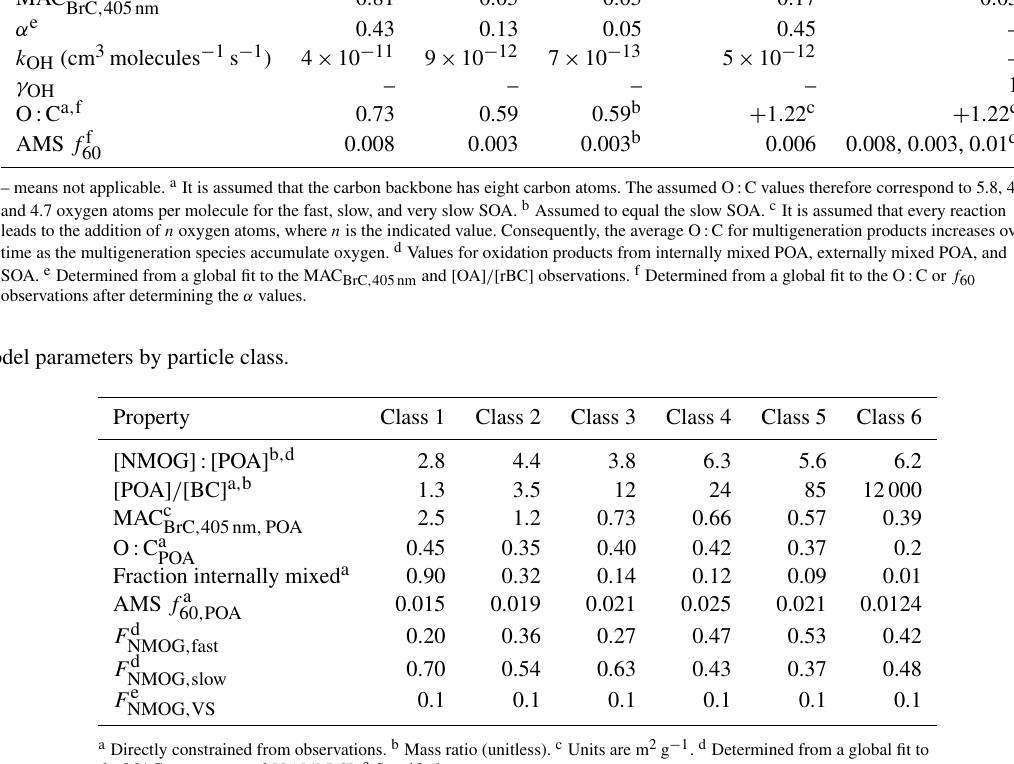
Table 1. Model parameters for NMOG. Property Fast